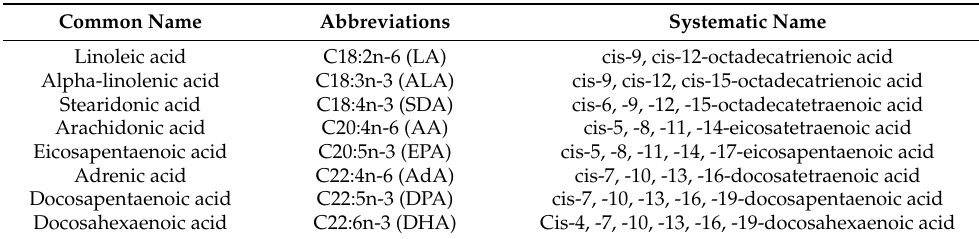
Table 1. Common name, abbreviation and scientific name (IUPAC, International Union of Pure and Applied Chemistry) of omega-3 (n-3) and omega-6 (n-6) fatty acids found in dietary